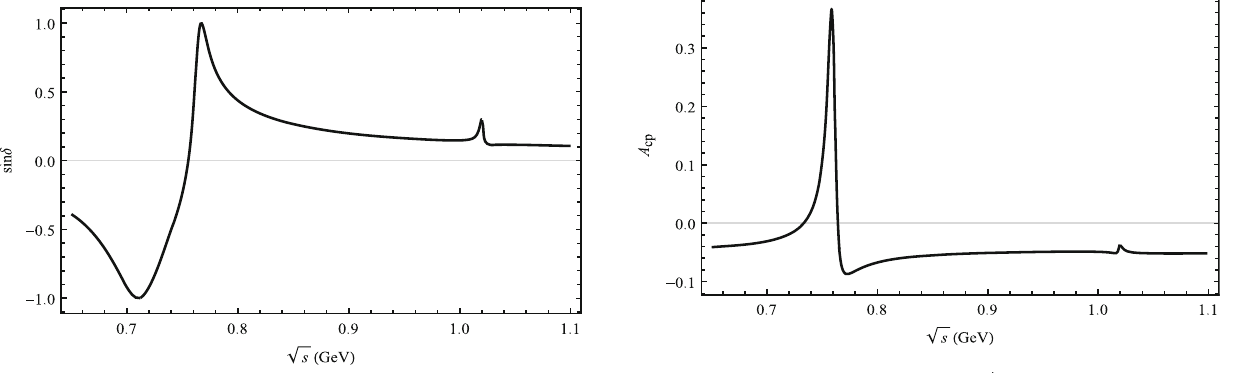
√ s corresponding to central